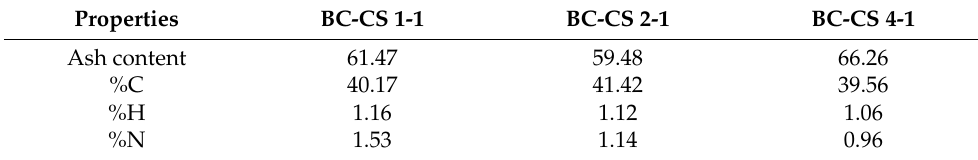
Table 1. Ash content and elemental analysis of BC-CS 1-1, BC-CS 2-1 and BC-CS 4-1.